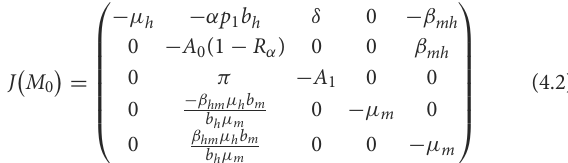
mosquitoes also increased as α